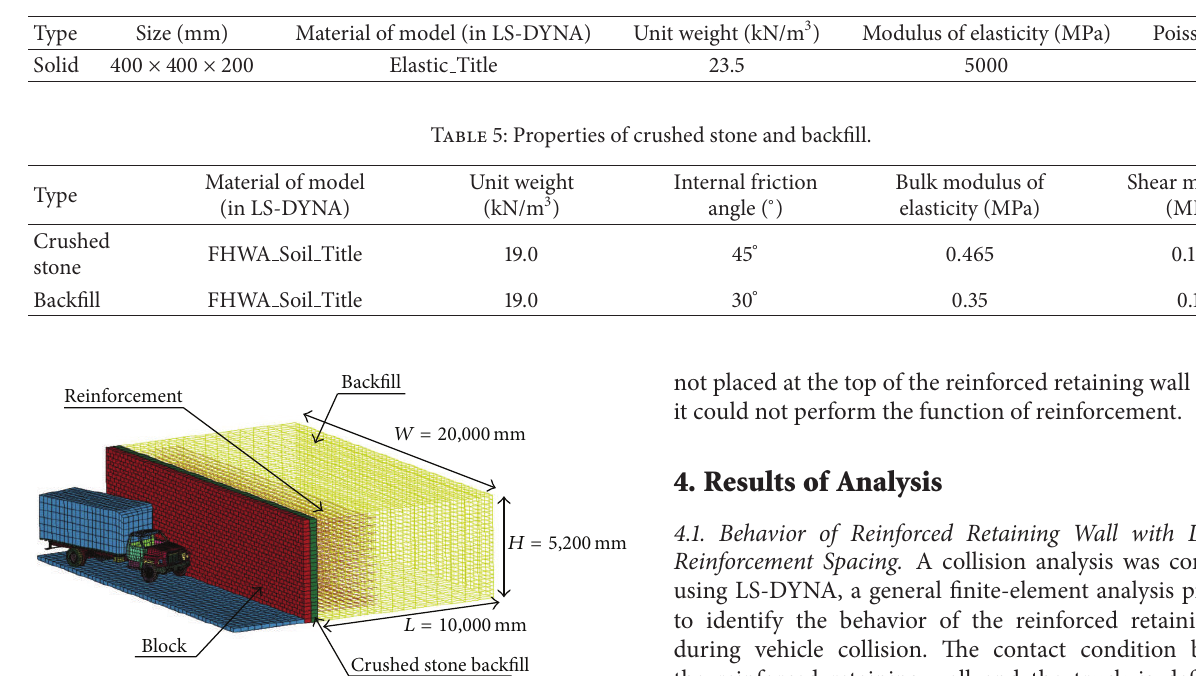
Table 4: Properties of reinforced retaining wall’s block.